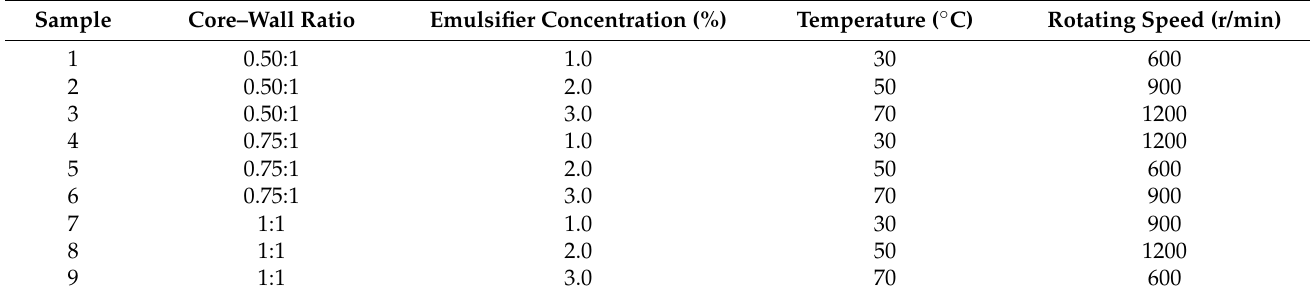
Table 2. Orthogonal experiment on the preparation parameters for microcapsules.